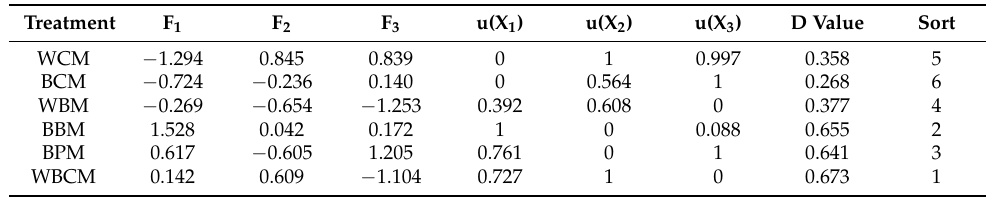
Table 5. Principal components, membership functions, comprehensive evaluation values (D), and rankings for different